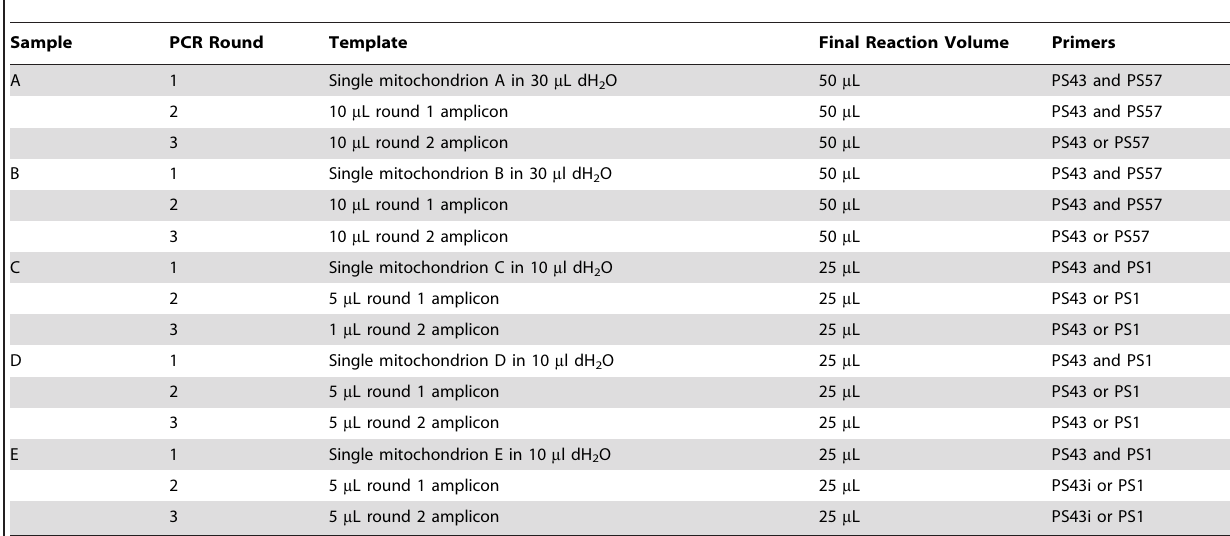
Table 4. Sample manipulation for PCR amplification of mtDNA from a single mitochondrion.